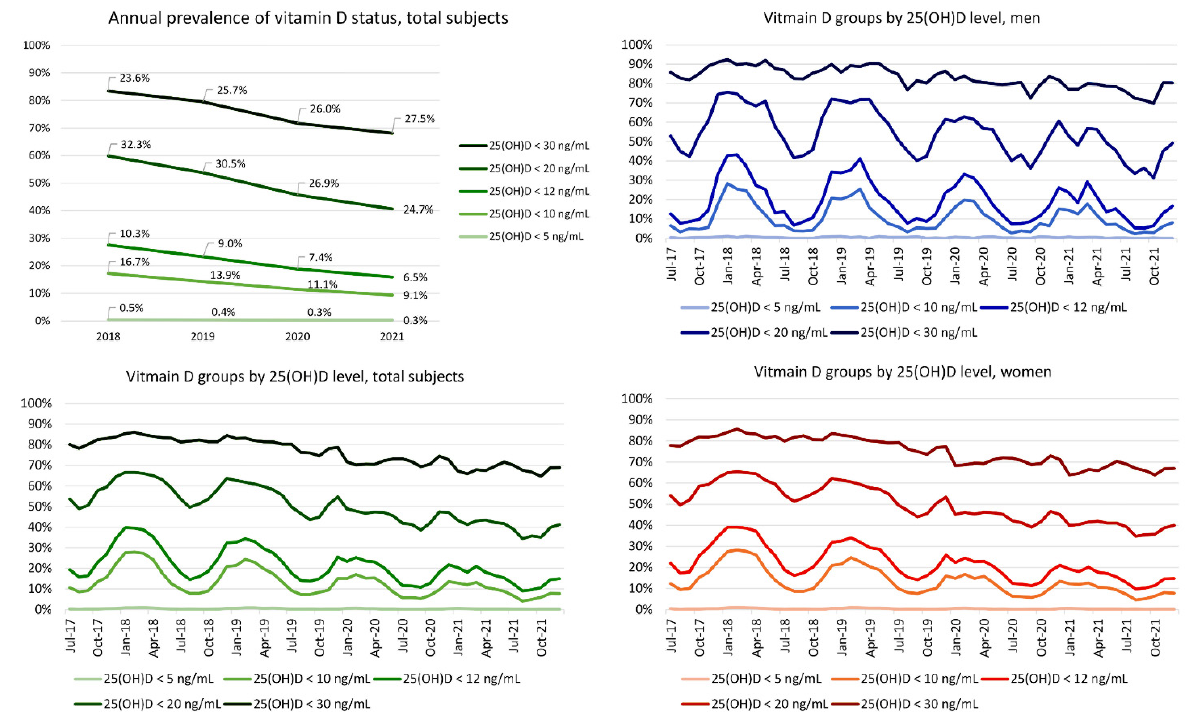
Figure 2. Median serum 25(OH)D level by sex, age, and test month. The total number of subjects with 25(OH)D level by month in the age groups of 70s and ≥ 80s was <100 for several months. Darker to brighter lines represent younger to older age groups. Men aged ≥ 80 years were not tested in some months.